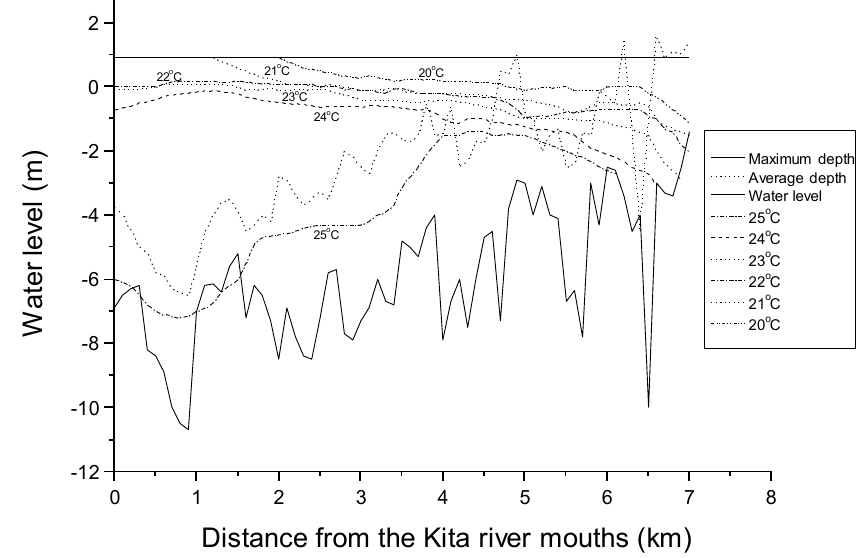
Figure 5. Water temperature distribution on a spring tide in the Kita River.